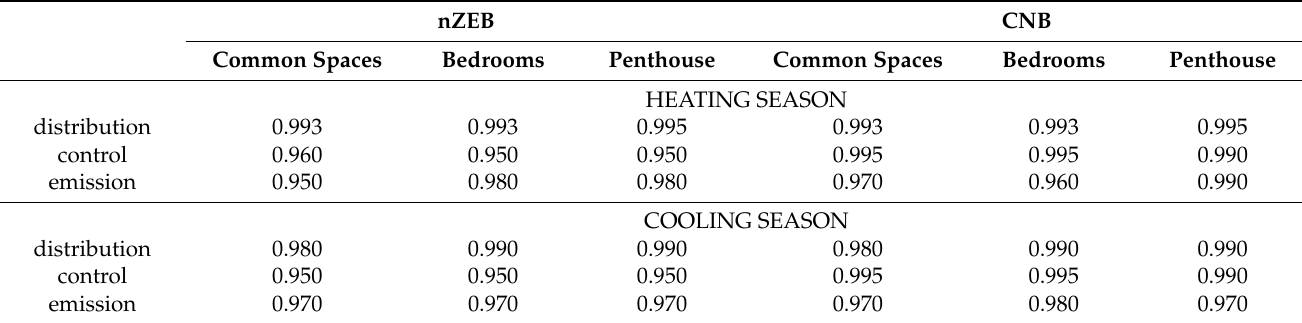
Table A2. Efficiencies of the distribution, control, and emission subsystems used for both scenarios investigated. nZEB